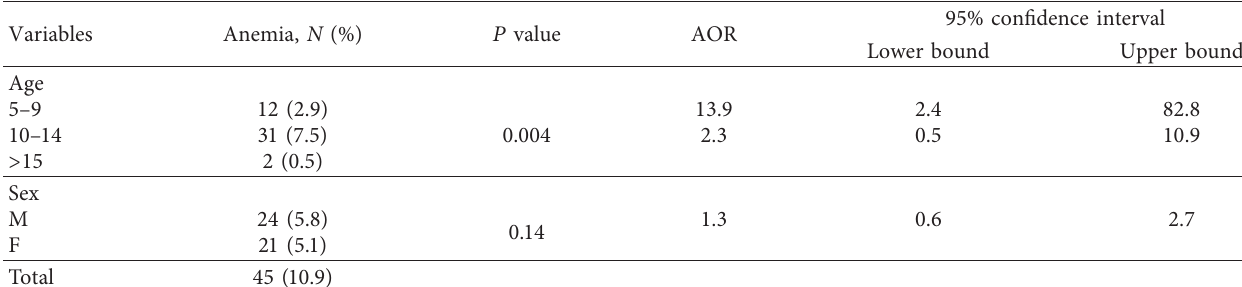
Table 6: Anemia level among the age and sex group of primary school children in Gedeo zone, Southern Ethiopia. Variables Anemia, N (%) P value AOR